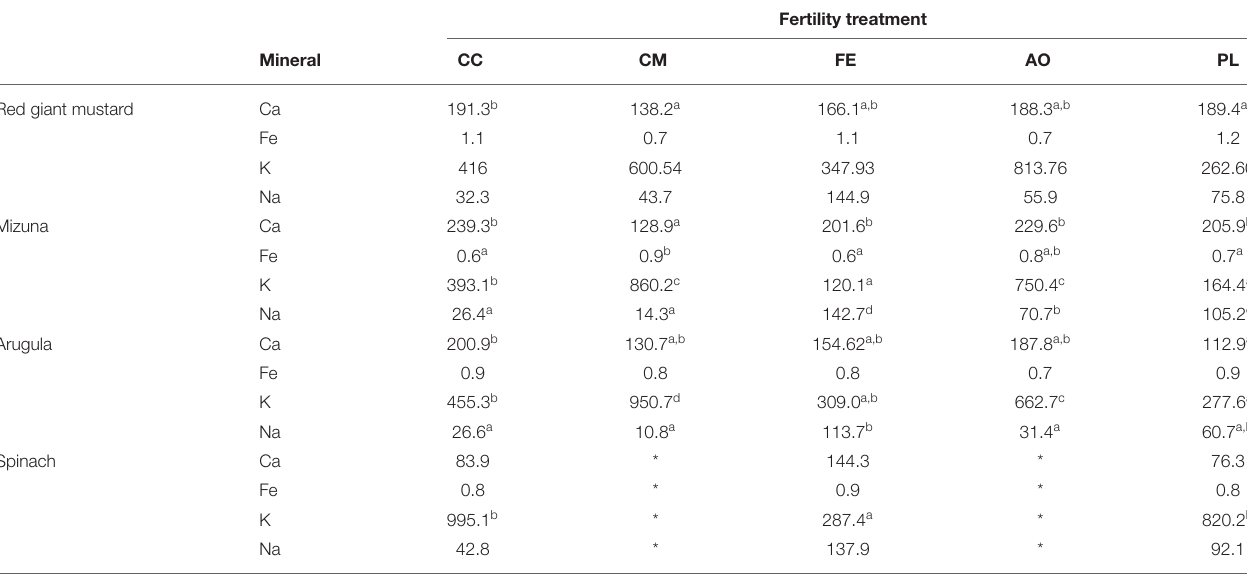
Data shown are mean (n = 3) for each respective species. Results analyzed using ANOVA Tukey HSD for significance testing (p < 0.05). Significance analyzed for each species within each experiment. * Indicates missing samples due to space capacity of experiment in greenhouse. a,b,c,d indicate means within a row followed by the same letter are not significantly different at p <